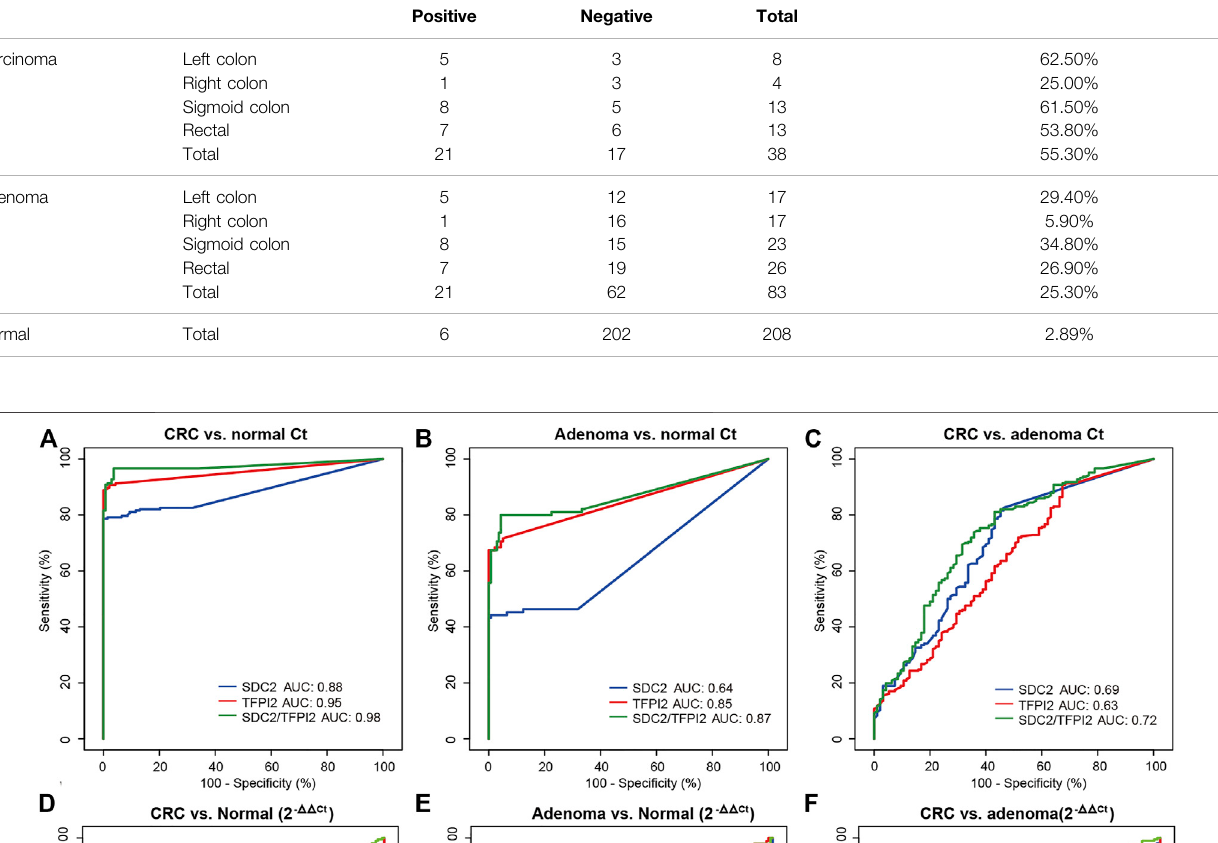
speci fi city of 99.30% and sensitivity of 44.20%. SDC2 / TFPI2 - combined detection showed better diagnostic performance than SDC2 detection alone for CRC vs. normal and for adenoma vs. normal as well as for adenoma vs. CRC. The AUC value of SDC2 / TFPI2 for CRC vs. adenoma was 0.72, with the speci fi city of 64.20% and sensitivity of 73.80%, which was lower than that of CRC vs. normal or adenoma vs. normal.